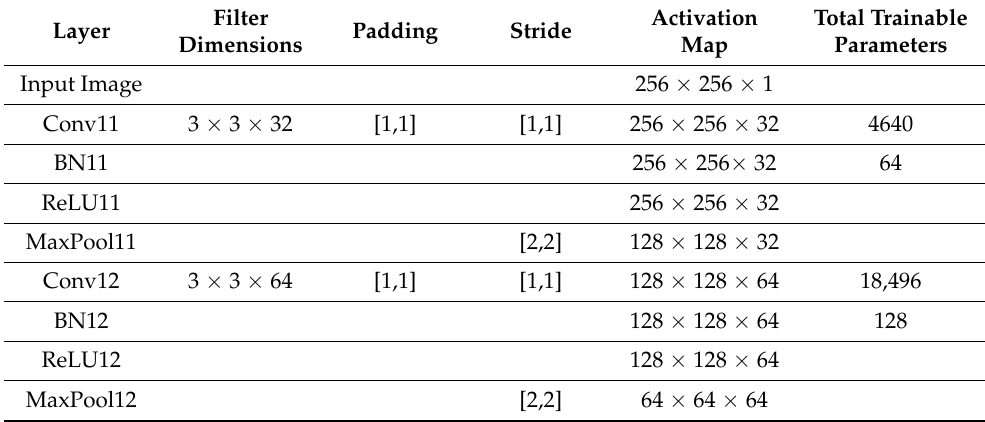
Table 1. Parameter specification of proposed CPDCNN.